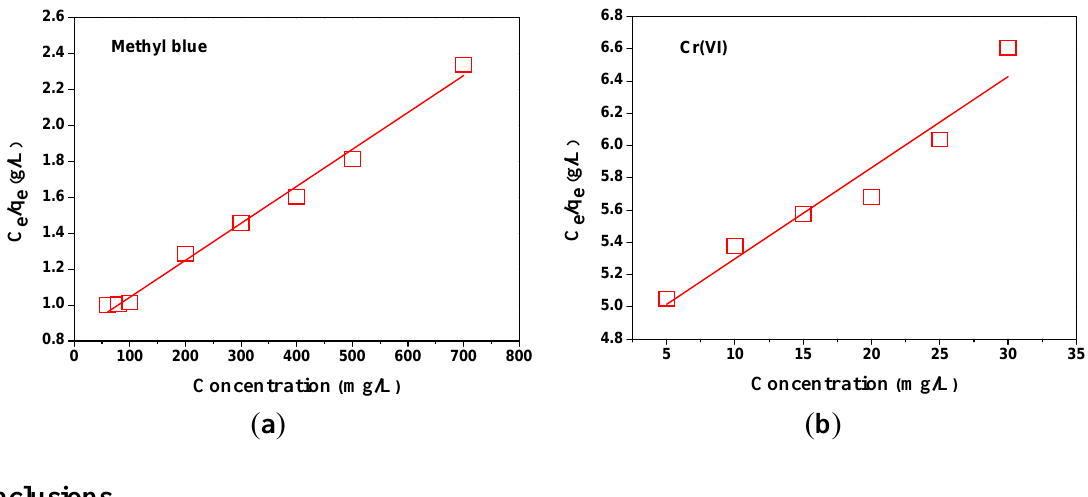
Figure 9. Langmuir adsorption isotherms for methyl blue solution ( a ) and Cr(VI) solution ( b ) by